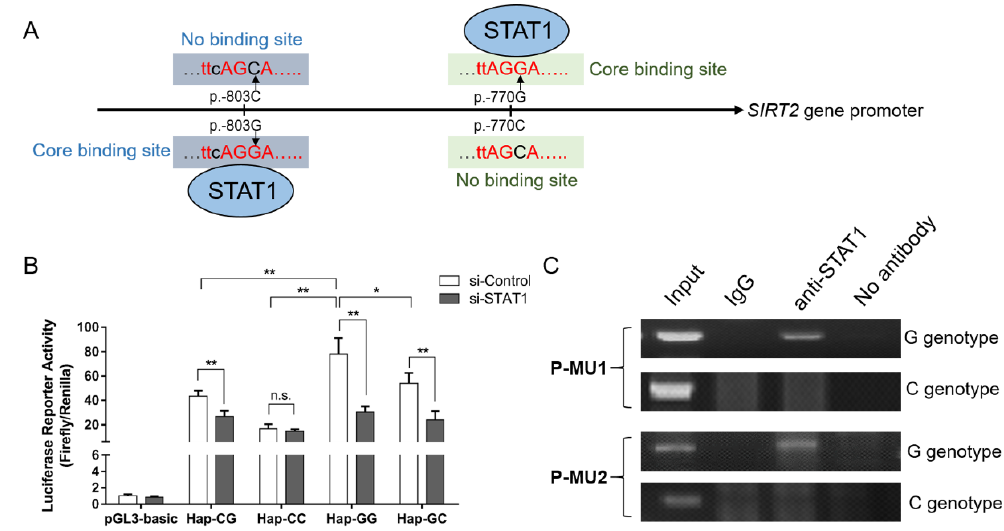
Figure 5. STAT1 can affect the promoter activity by binding to the SIRT2 promoter variants. ( A ) Putative binding sites of STAT1 were disrupted by the P-MU1 and P-MU2 loci. ( B ) STAT1 affected SIRT2 promoter activity by a reporter assay. ( C ) STAT1 binds to promoter sequences with allele G of the P-MU1 and P-MU2 loci by a ChIP assay. Data were given as the mean ± SE. * p < 0.05 or ** p < 0.01 shows a significant difference; n.s. represents no significance.